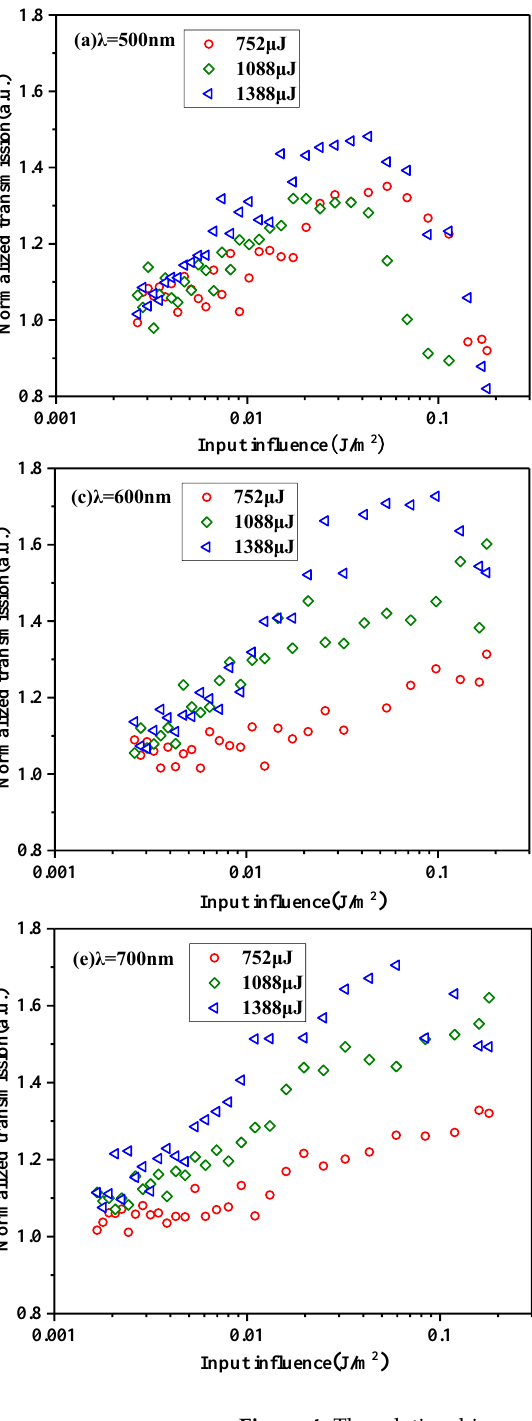
Figure 4. The relationship curve between the normalized transmission of PtNPs and the incident laser pulse energy density under different wavelengths of ( a ) 500 nm, ( b ) 550 nm, ( c ) 600 nm, ( d ) 650 nm, and ( e ) 700 nm. The dotted lines were experimental